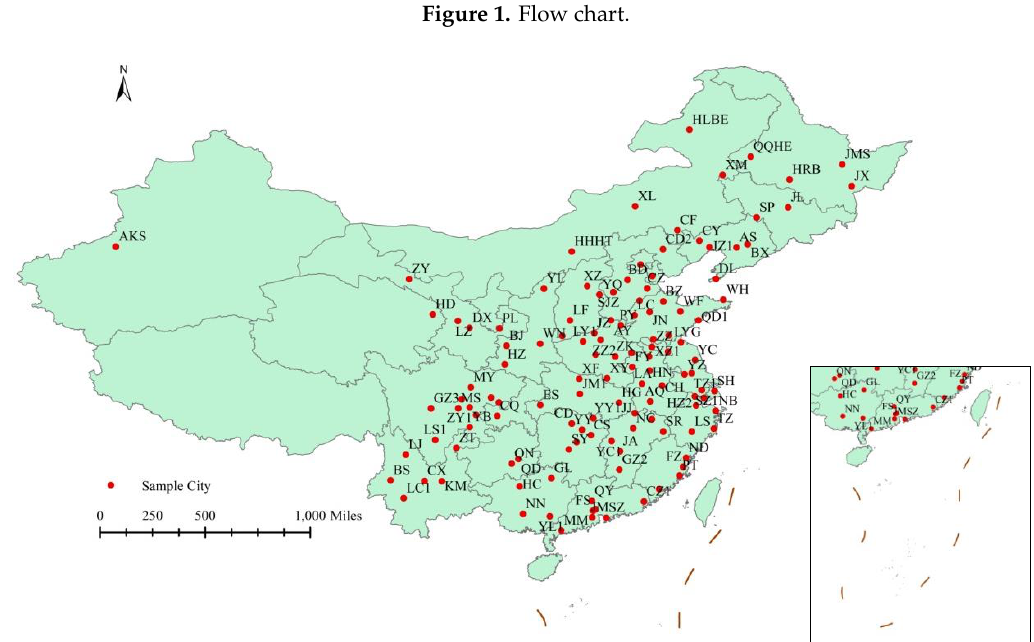
Int. J. Environ. Res. Public Health 2019 , 16 , x FOR PEER REVIEW